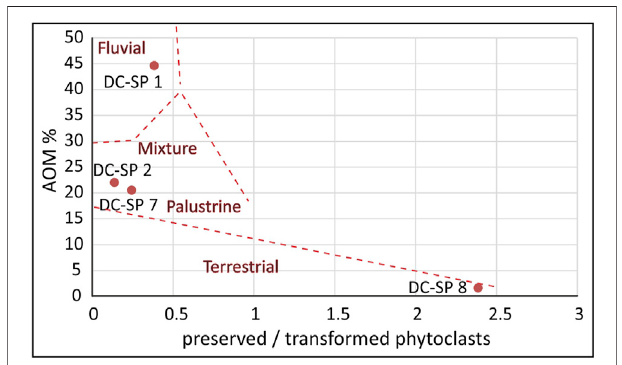
FIGURE 10 | Diagram for discrimination of depositional environments according to palynofacies analysis applied to samples from DC-SP pro fi le in the Lower Cerova ˇ cka Cave with optical indices “ AOM contents ” (aquatic or microbial production) and “ preserved/transformed ratio ” (preservation degree of terrestrial plant debris) (according to Sebag et al.,